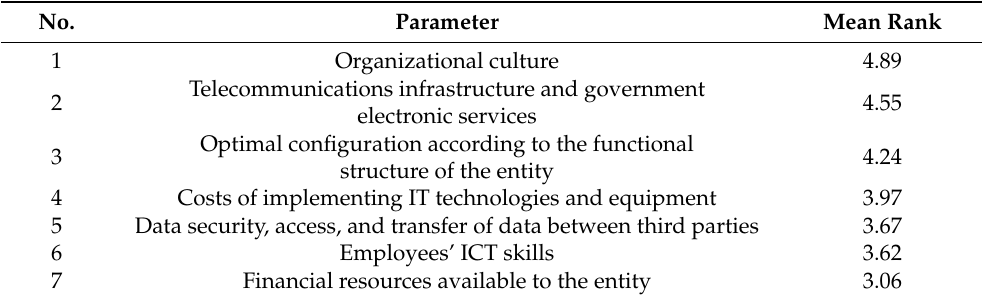
Table 3. Hierarchy of factors influencing the decision of